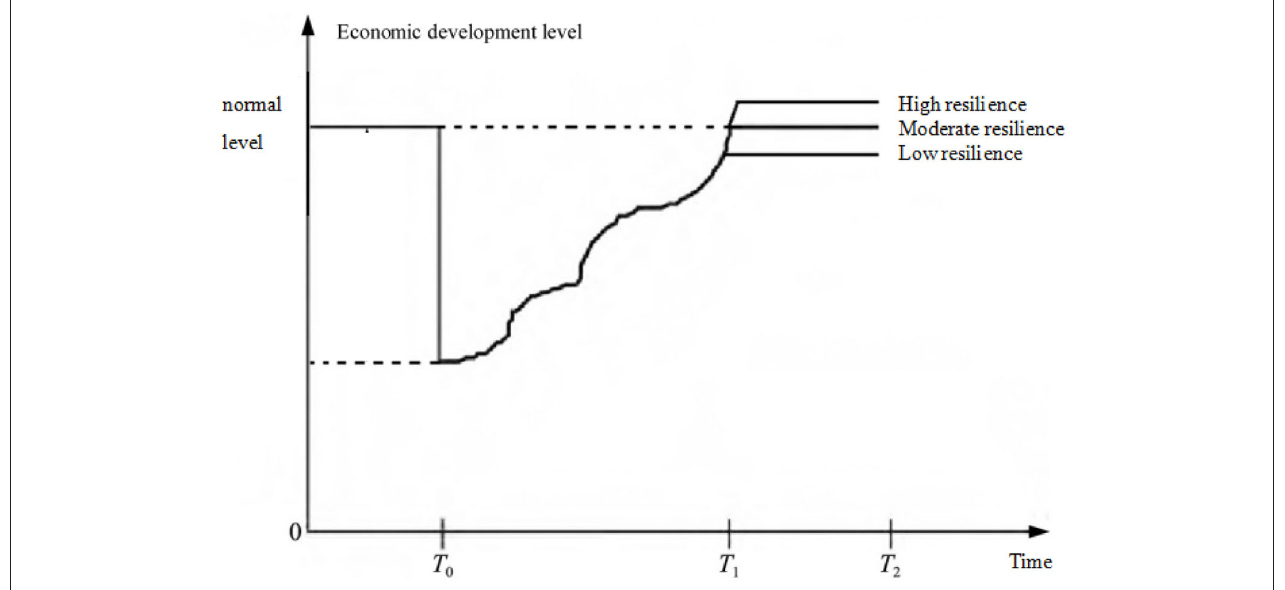
FIGURE 1 | Economic development after the